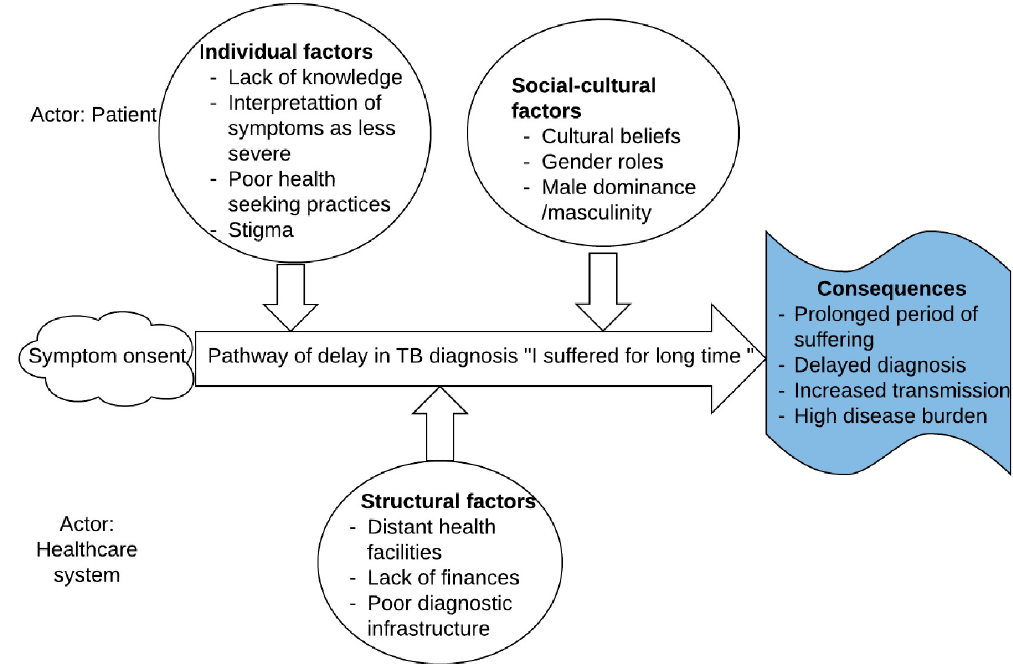
Fig 3. Conceptual framework of factors leading to delay in TB diagnosis in West Pokot